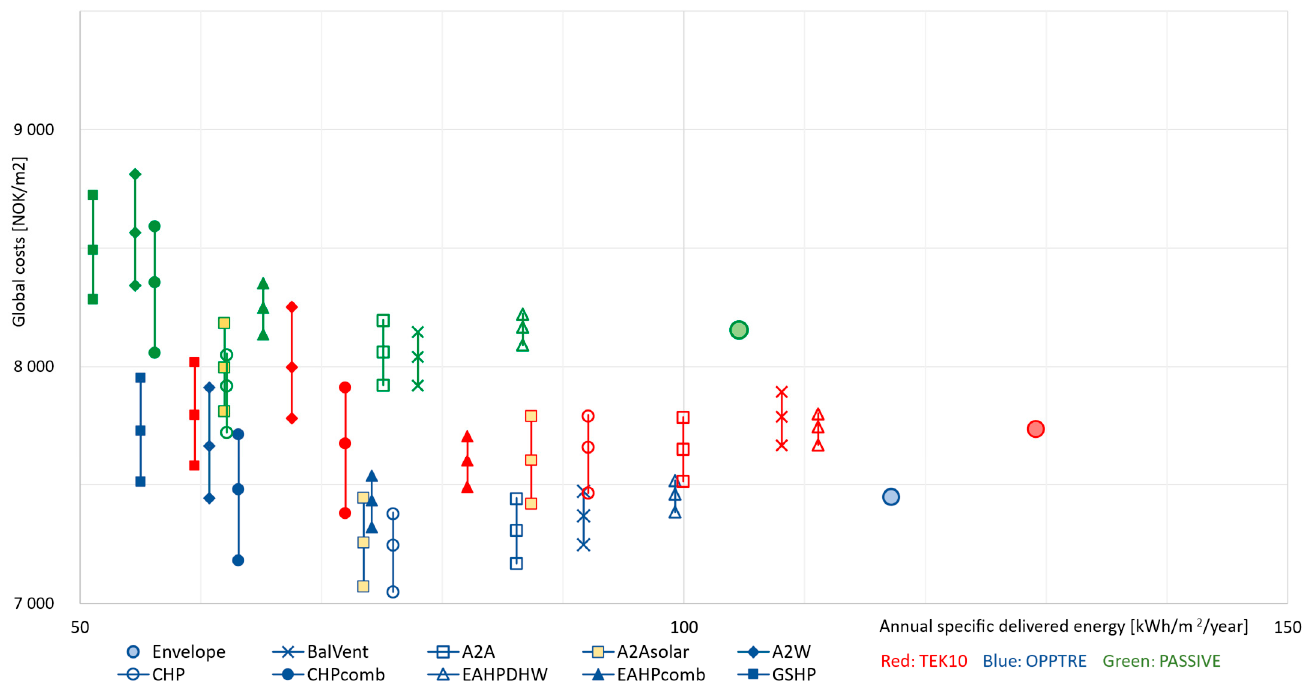
Figure A2. Difference in total specific energy costs between power tariff and original tariff for the calculation period of 20 years and the alternative case with no nighttime heating setback.